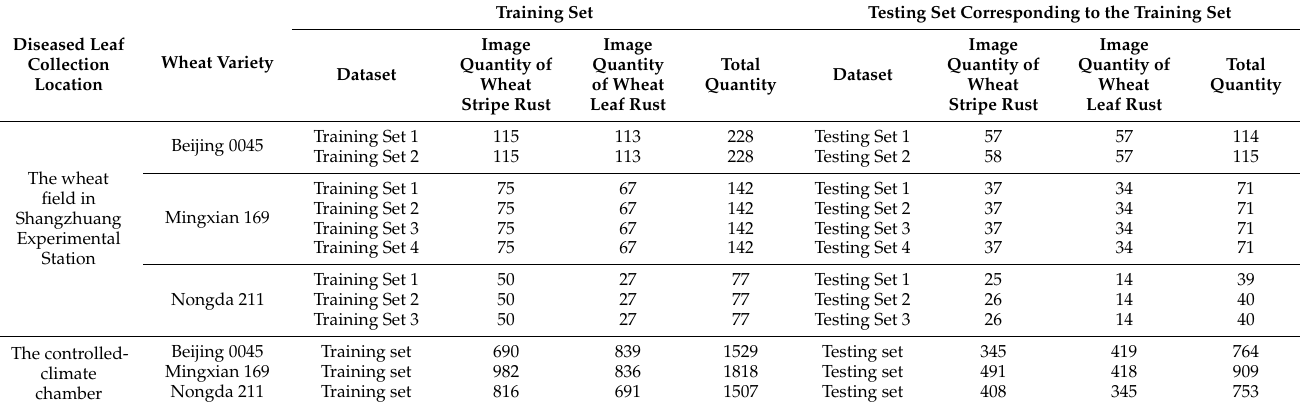
Table 3. Training and testing sets constructed for disease-identification modeling by using the acquired images of stripe rust and leaf rust on different wheat varieties from the wheat field in Shangzhuang Experimental Station and the controlled-climate